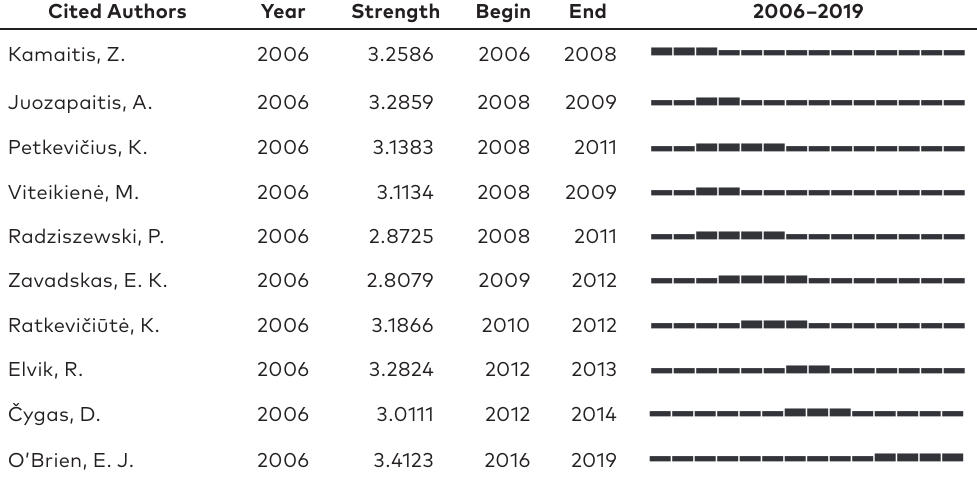
Table 9. Top sixteen cited journals with the strongest citation bursts